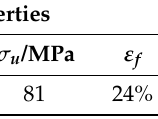
Table 1. Chemical compositions and mechanical properties of polycrystalline aluminum. Chemical